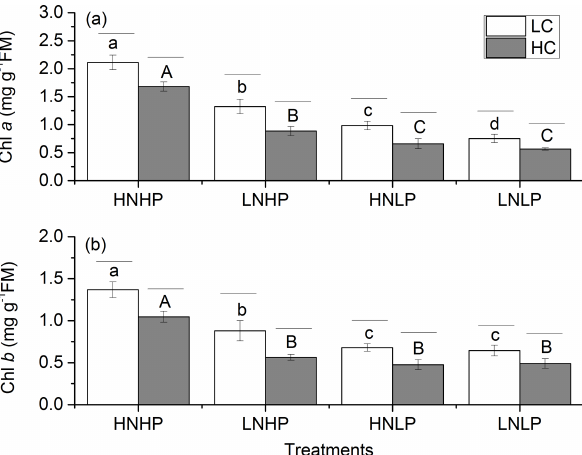
Figure 6. Nitrate reductase activity (NRA) in adult U. linza grown under various conditions. LC, 400µatm; HC, 1000µatm; LN, 6.1µmolL − 1 ; LP, 0.2µmolL − 1 ; HN, 106.1µmolL − 1 ; HP, 10.2µmolL − 1 . The error bars indicate the standard deviations ( n = 3). Different letters (lower case for LC and capital for HC) above the error bars represent significant differences ( P < 0.05) among nu- trient treatments while horizontal bars represent significant differ- ences ( P < 0.05) between LC and HC within a nutrient